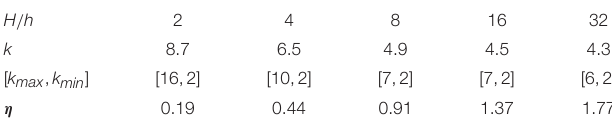
TABLE 1 | The performance gain between the patch method and the standard one (without patch and with the same level of refinement everywhere) for the case of Figure 5 (black dashed line, H = λ/ 320) estimated using formula (28), with k being the average number of iterations needed for convergence in the patch algorithm per wave cycle ( k max and k min are the maximum and the minimum number of iterations, respectively), α = 10, β = 2,4,8,16,32 and D =